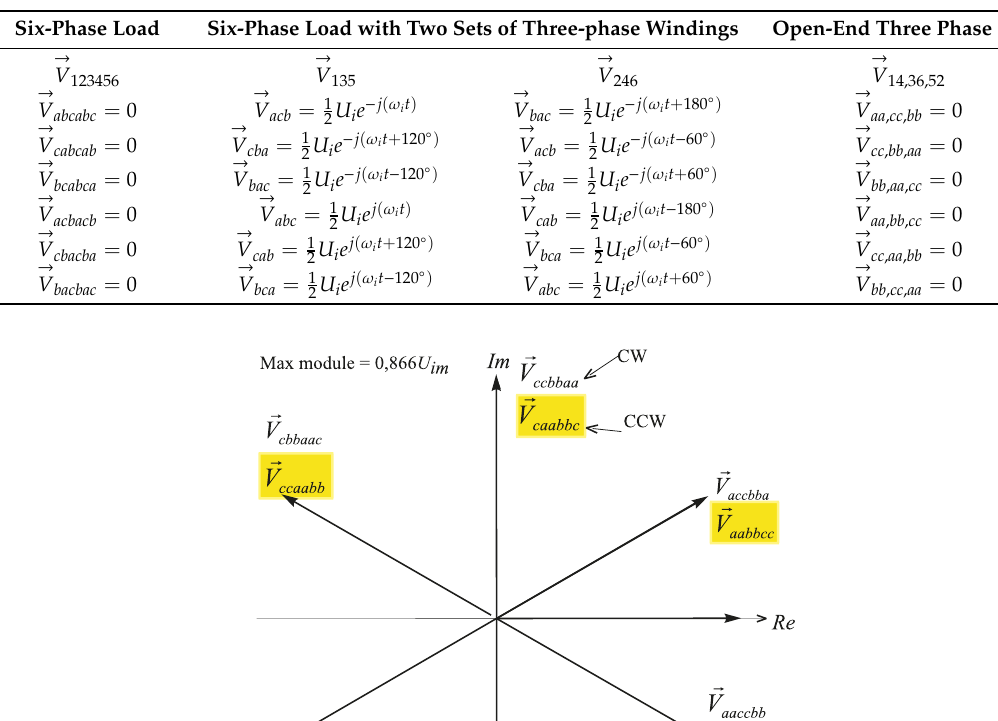
Table 2. The names and relations defining the zero space vectors resulting in elimination of the CMV.